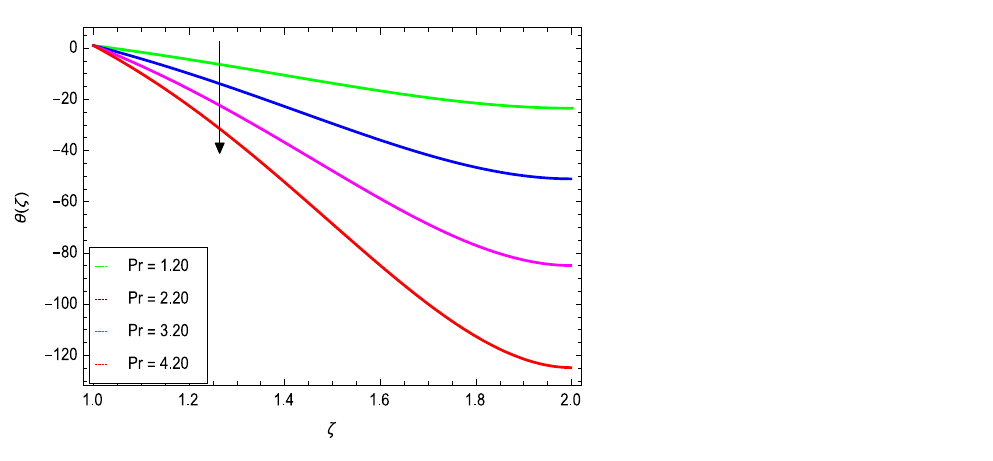
Figure 9. θ (ζ) as a function of Pr .